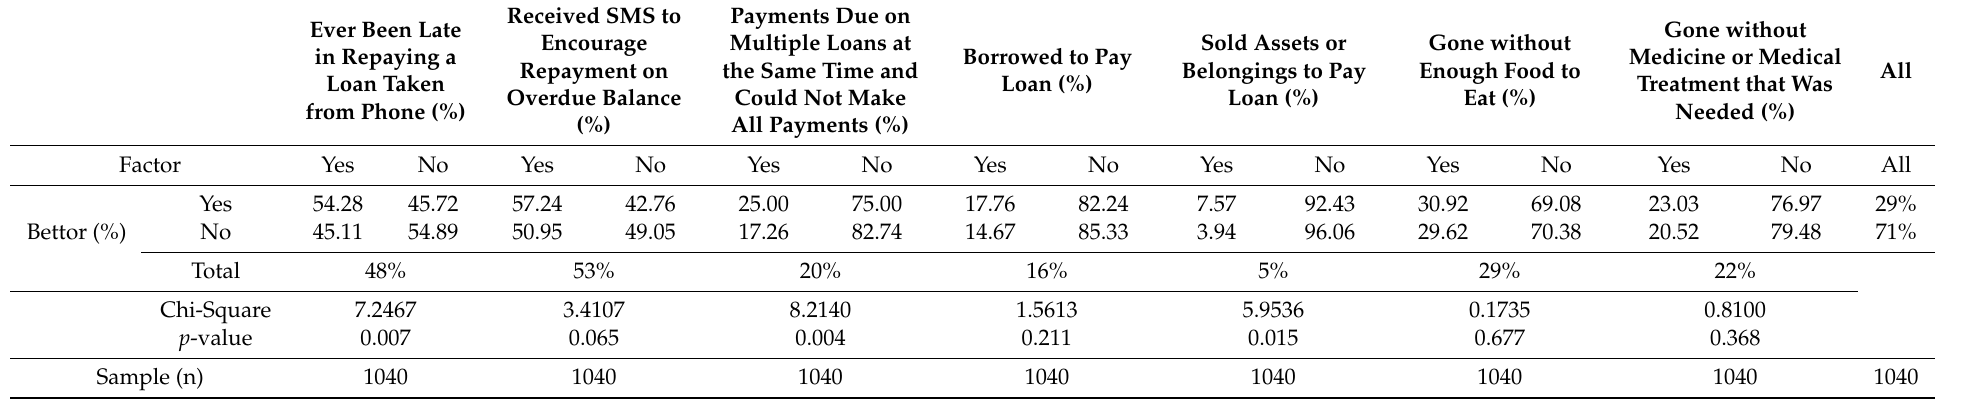
Table 2. Bivariate relationship between betting and digital credit repayment/coping strategies/welfare